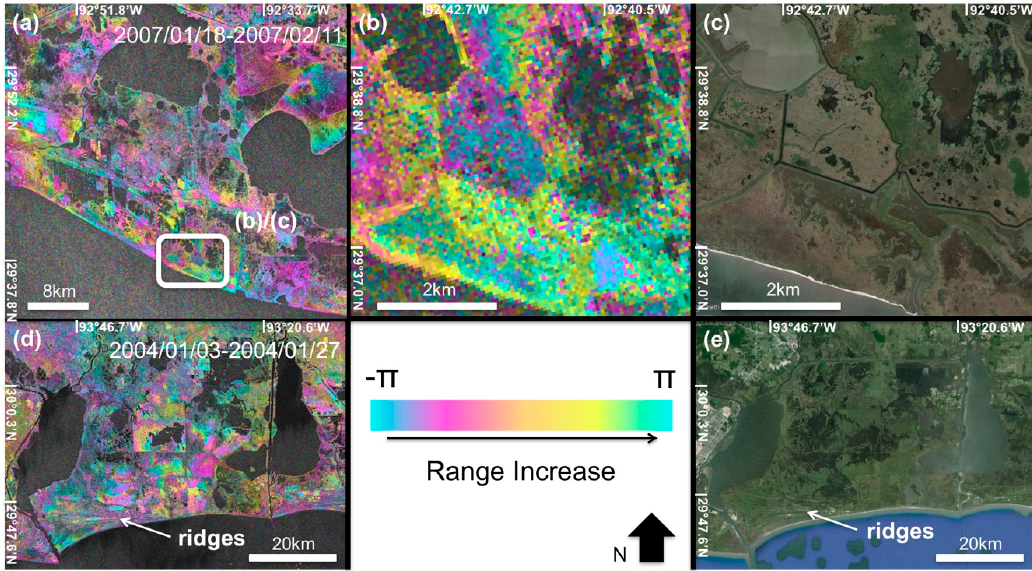
Figure 4. ( a ) Radarsat-1 interferograms of the central part of the Chenier Plain spanning 24 days (18 January 2007–11 February 2007). The white square shows the location of figures ( b , c ); ( b ) Zoom in showing fringe discontinuities sub-parallel to the coastline that coincides with man-made canals observed in the Google Earth image ( c ); ( c ) Google earth image of the same area; ( d ) Radarsat-1 interferogram of the western Chenier Plain spanning 24-day period (3 January 2004–27 January 2004). In the central part of the interferogram fringe patterns show changes in inland water bodies. The white square on the left side of the interferogram shows fringe patterns due to the morphology of the Chenier reflecting water level changes in the mudflats in between the ridges of the Chenier’s; ( e ) Google earth image of the same study area.